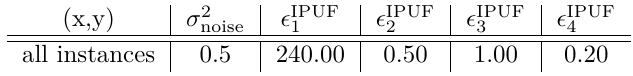
Table 6: Constraints for single-pass experiments in Table 3 and the combined reliability attack in Figure 7.